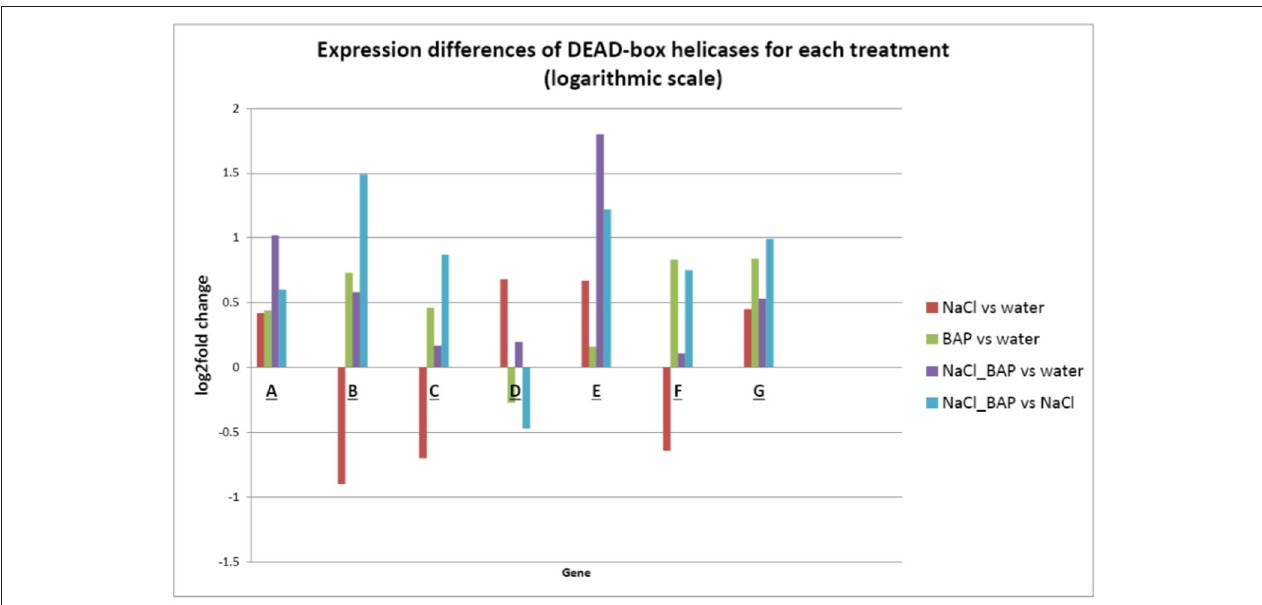
FIGURE 8 | Effect of CK on differential expression of DEAD-box helicases (logarithmic scale). A bioinformatics scan (DESeq 2 software) was employed to identify functional groups related to the CK-induced stress resistance mechanism. The expression of 7 DEAD-box ATP-dependent RNA helicases genes were significantly changed by CK under salt stress ( P < 0.05). (A) DEAD-box RNA helicase family protein (AT4G16630); (B) DEAD-box RNA helicase family protein (AT3G18600); (C) STRS1 (AT1G31970); (D) DEAD-box RNA helicase family protein (AT3G58570); (E) AtRH9 (AT3G22310); (F) PRH75 (AT5G62190); and (G) AtRH2/ STRS2